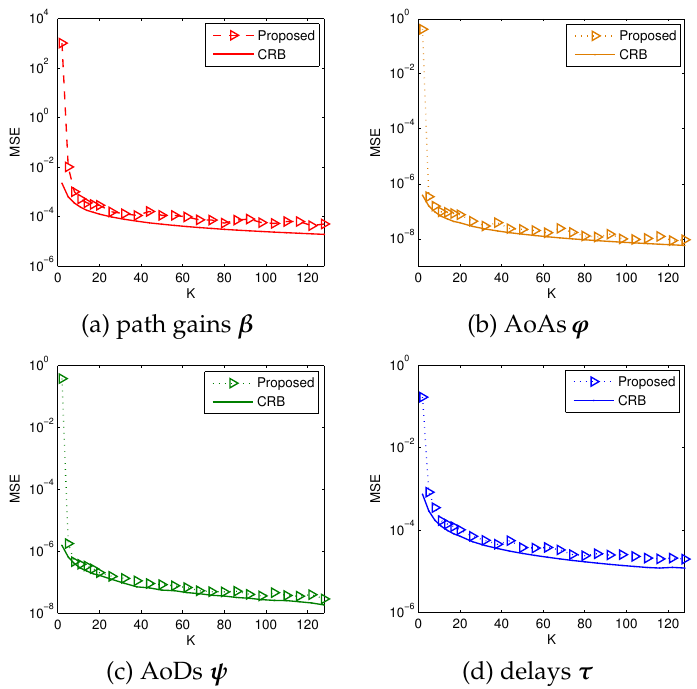
Figure 3. MSEs and CRBs of channel parameters versus K .